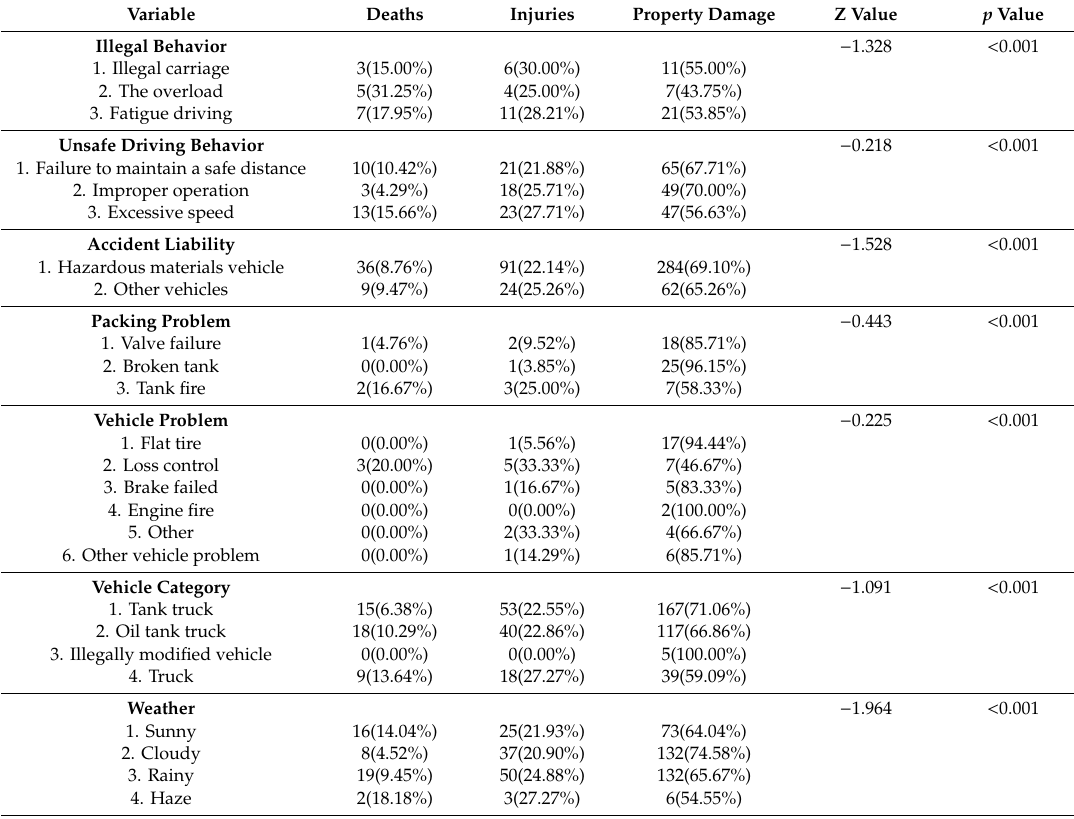
Table 2. Analysis of factors influencing the severity of hazardous materials transportation